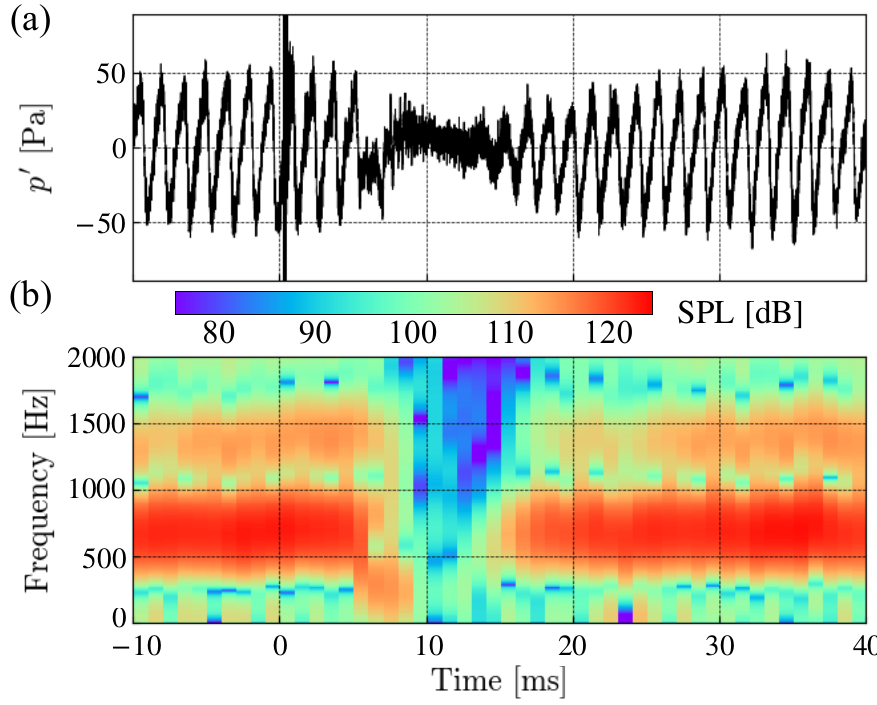
Figure 6. ( a ) Unsteady surface pressure fluctuation p (cid:48) measured at x = 225 mm (90% chord position). ( b ) Spectrogram of ( a ). The width of the time window is 4